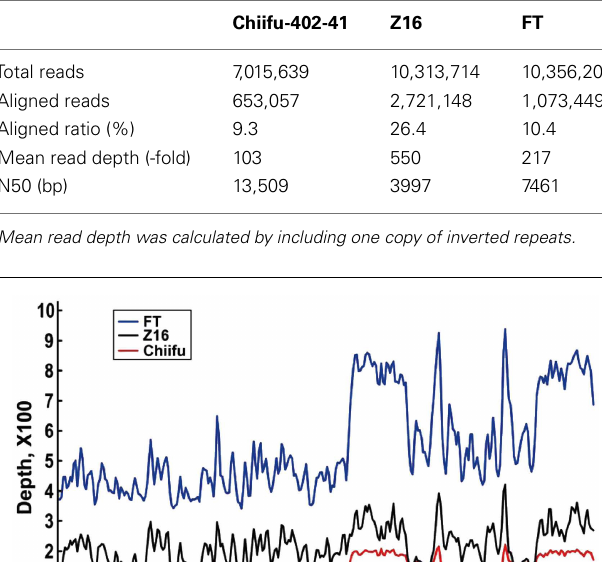
Table 1 | Characteristics of reads from one lane sequencing on Illumina Solexa 1G Genome sequencer.